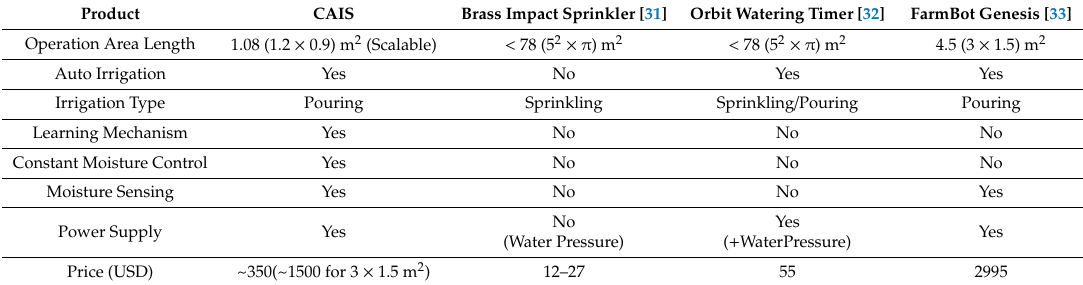
Table 3. Operational characteristics of CAIS vs. other existing products or